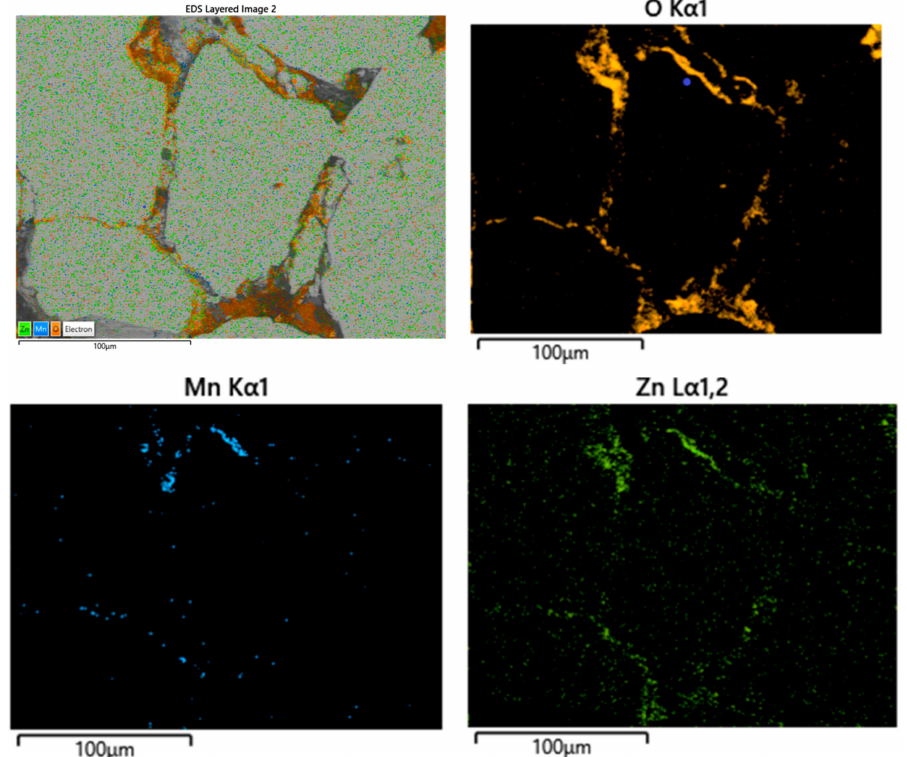
Figure 5. The microstructure and the phase distribution (EDX, elements distribution maps) in the composite compacts obtained from Ni 3 Fe@Mn 0.5 Zn 0.5 Fe 2 O 4 (3 wt.%) pseudo core–shell powders by SPS at 600 C, 10 min. In the top left side is shown the SEM image of the microstructure with the ferrite elements’ distribution maps